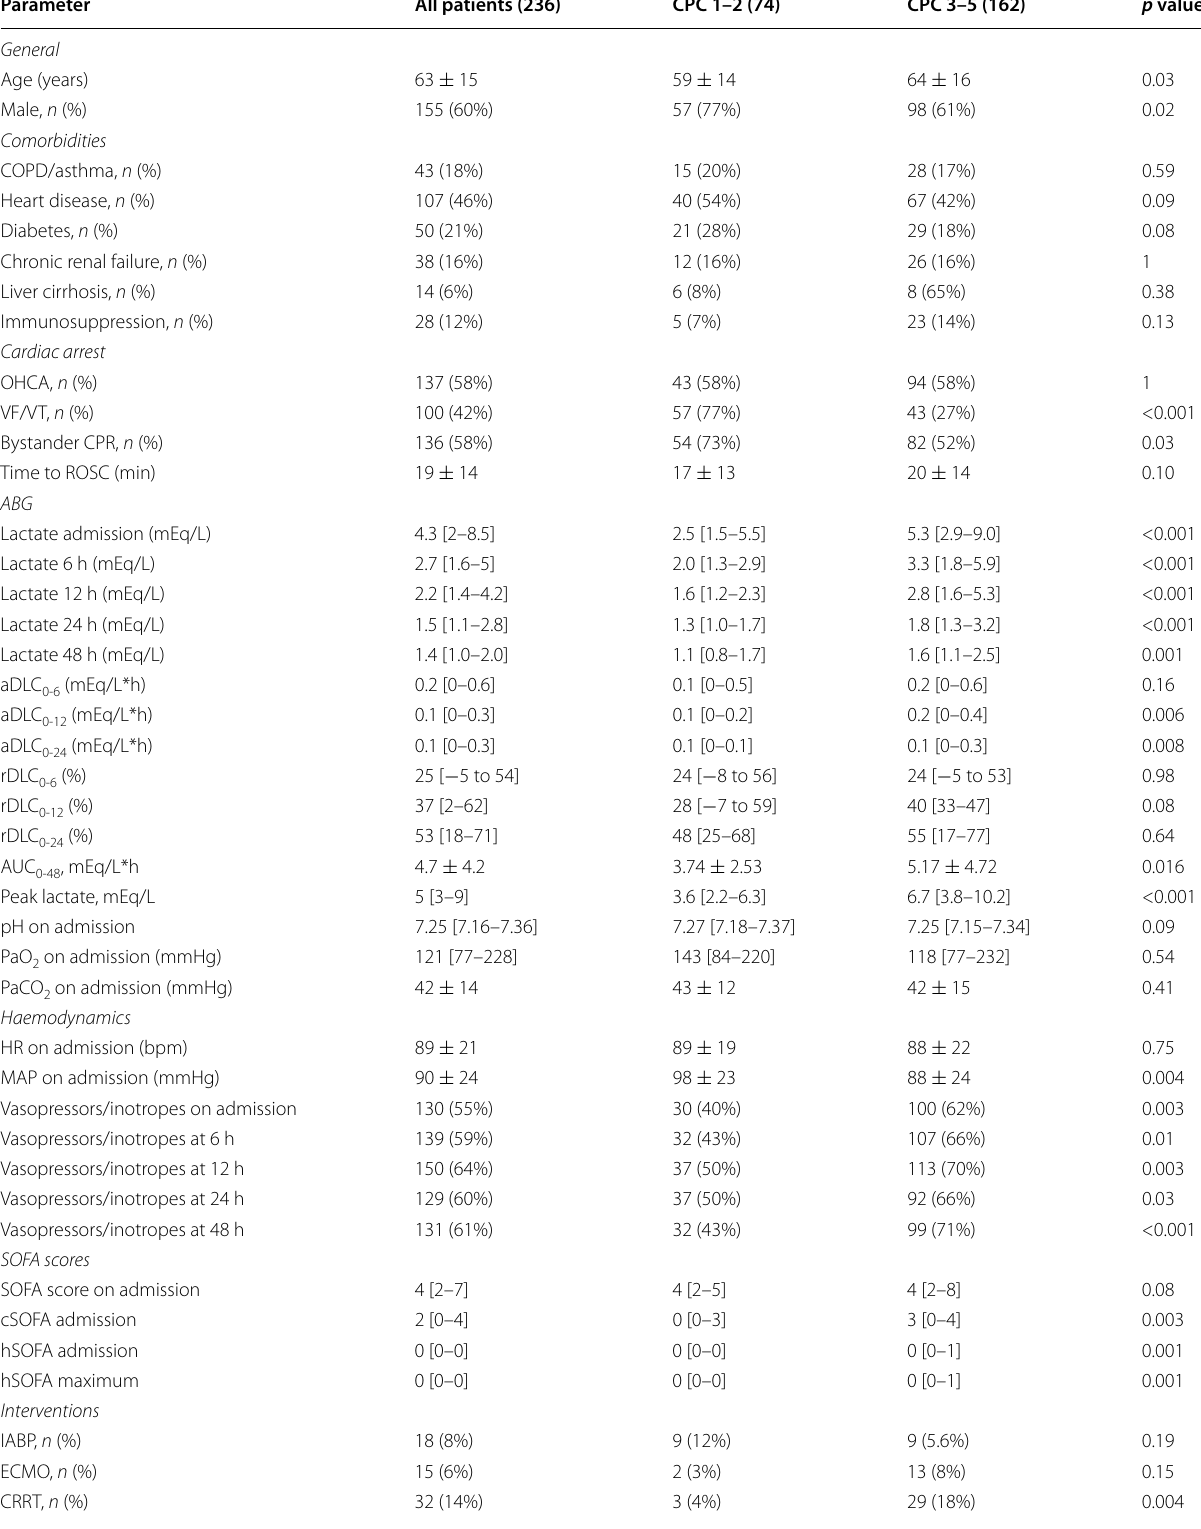
Table 1 Characteristics of study population according to neurological outcome at 3 months Parameter All patients (236) CPC 1–2